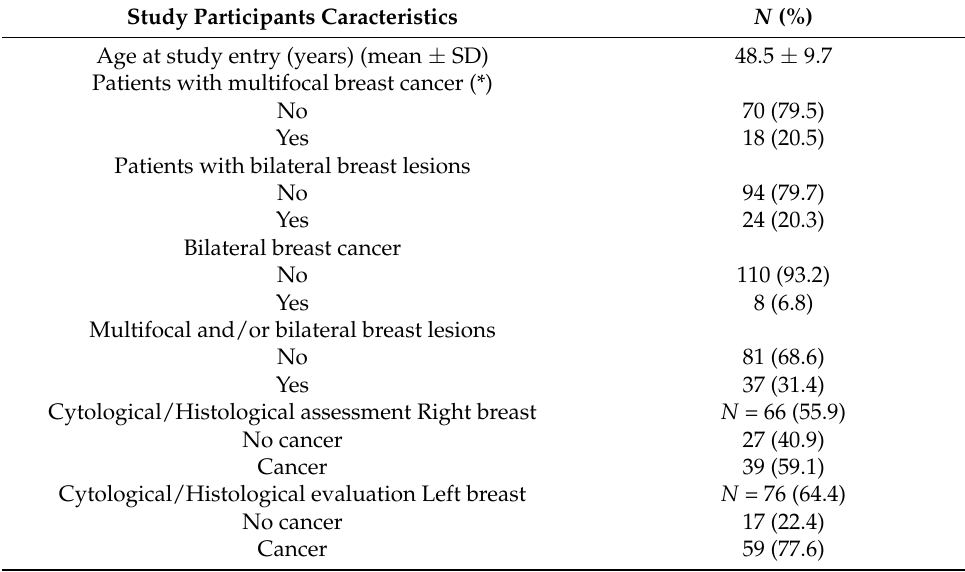
Table 2. Characteristics of the study participants ( N =